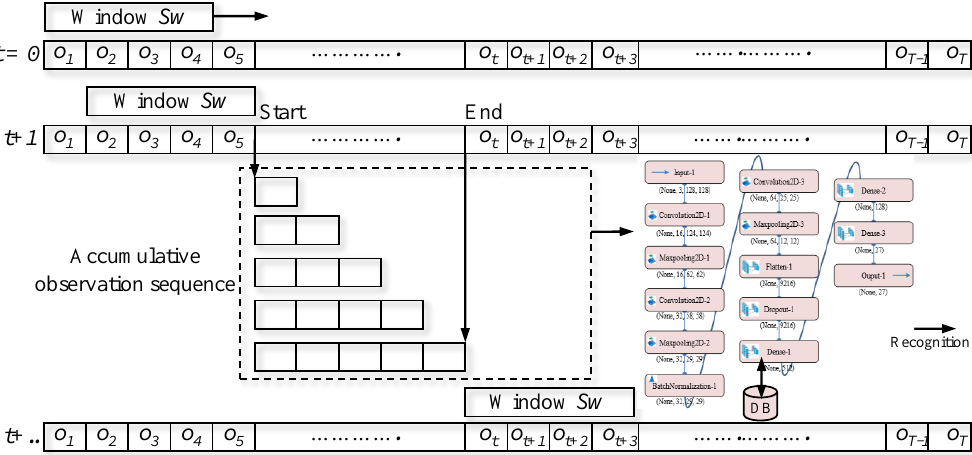
Figure 11. Block diagram illustrating how sliding windows